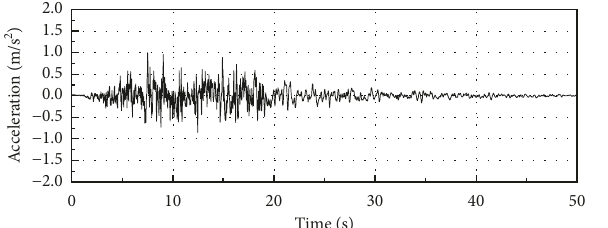
Figure 14: Displacement response curve of intensity 7 frequently of Imperial Valley (transverse input).